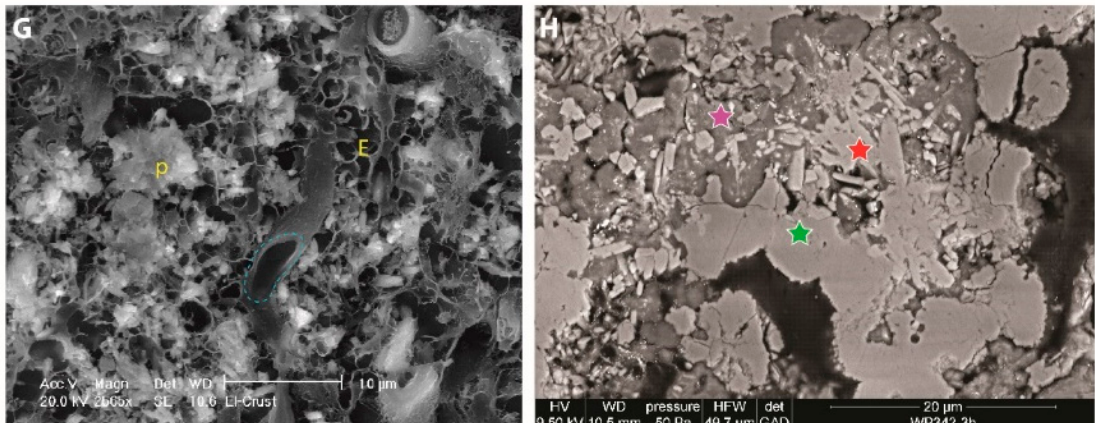
Figure 19. Macrofabrics, microfabrics, and microstructures of modern microbialites from the Bahamas and the Great Salt Lake (USA). ( B , C ) are thin section photomicrographs. ( D – G ) have been taken with an FEG-ESEM equipped with a cryotransfer unit. ( H ) has been taken with an FEG-SEM. ( A ) Thrombolitic crust growing in high energy oobioclastic sands, encrusted by red algal bushes (purple arrow) on Highborne Cay beach (Bahamas). ( B ) Peloids (p) precipitated in the stromatolites of Big Pond Lake (Figure 18C,D) and rimmed by a microspar fringe (blue arrow). The scale bar is 100 µ m. Polarized light. ( C ) Alternating vertical and horizontal calcified filaments of Scytonema (Storrs Lake, Bahamas). The scale bar is 100 µ m. Plane polarized light. ( D ) Ooids trapped and bound by vertically oriented Schizotrix filaments in open marine stromatolites of Highborne Cay (see also Figure 18H). ( E ) Coccoid ( Gloeocapsa sp. and / or Entophysalis sp.; green arrow) and filamentous ( Phormidium sp. and / or Microcoleus sp.; blue arrow) cyanobacteria embedded in a lithifying EPS matrix (E), showing a typical alveolar (tectic) structure. Note that the precipitation is initiated within the EPS matrix and not on the bacteria itself. Peloids (p) are made of high magnesian calcite. Salt Pan, Eleuthera, Bahamas. ( F ) Same sample as ( E ), with a close up view of coccoid cyanobacteria. (Salt Pan, Eleuthera Island). ( G ) Same as ( E ), but this part of the mat is dominated by filamentous cyanobacteria. The cyanobacteria section (highlighted in blue dots) strongly resembles the bean-like structures of Figure 11D. ( H ) Image of a Holocene thrombolite from the Great Salt Lake (UT, USA). Magnesian silicates form dark-grey globules (purple star) associated with “rice-grain” aragonite crystals (red star). A reaction between these two metastables minerals and degraded EPS could result in the formation of the surrounding dolomite globules (green star).